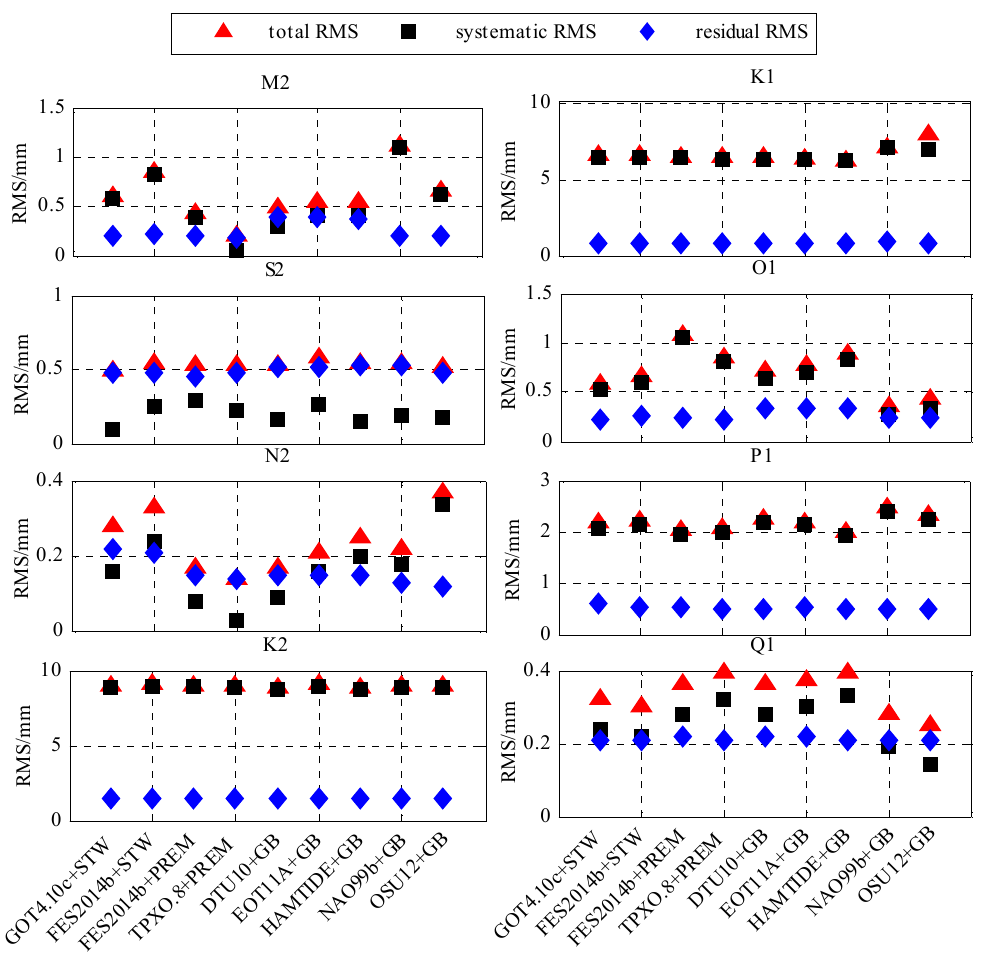
Figure 5. RMS values of the eight tidal constituents between the GPS estimates and the nine OTL models.